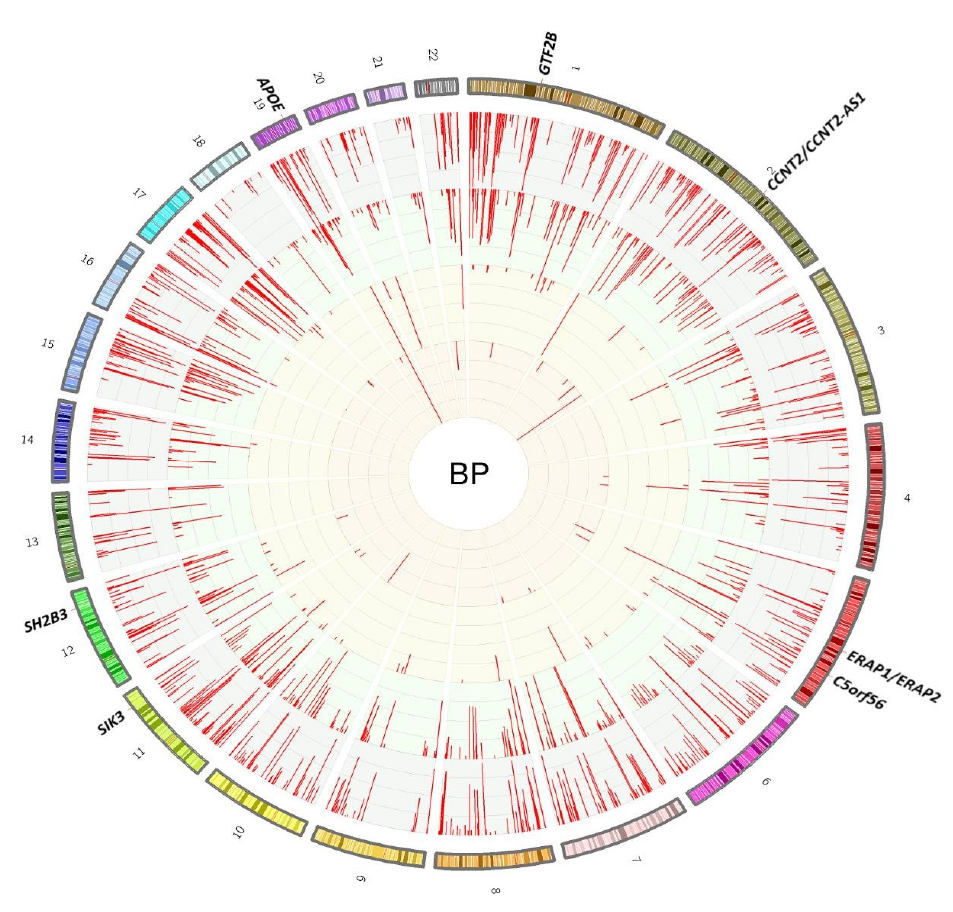
Figure 2. In silico lookup of BP loci associated with different molecular traits at the genome-wide significance level ( p < 5 × 10 − 8 ; from QTL tests). The outer layer represents the genomic position of variants with QTL associations and is split up into 22 chromosomes with banded colours showing the cytobands. The inner layers with red lines (from the outer one to the inner one) are as follows: DNA methylation, transcription, protein, and metabolite levels. The height of the red lines is representative of − log 10 (P). The seven assigned loci are those with evidence of simultaneous associations with all four molecular